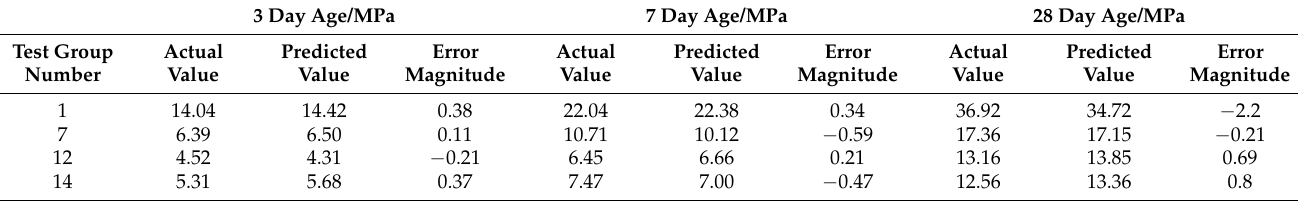
Table 9. Residual value of compressive strength at different curing